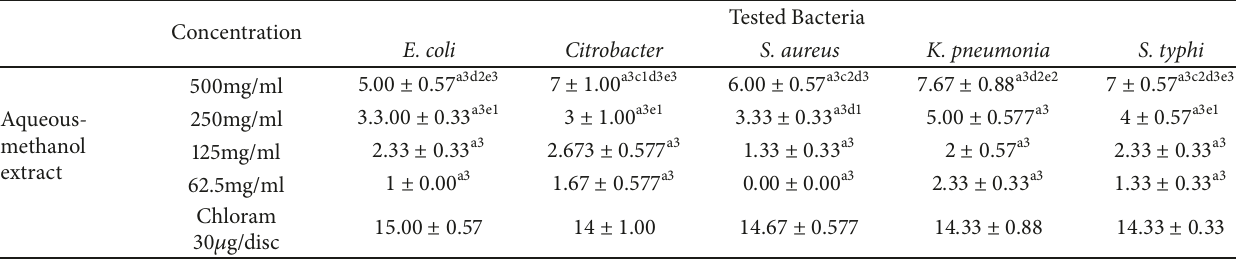
Table 2: Zone of inhibition mean (in mm) of plant extract for tested bacteria. Concentration